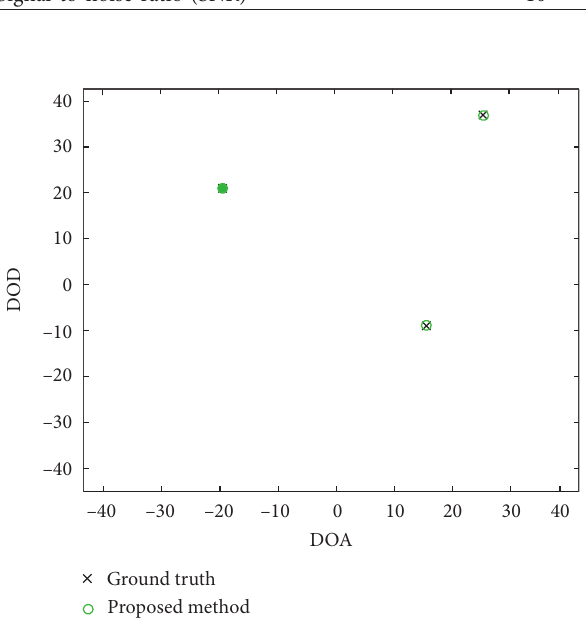
Figure 2: Location finding of the proposed algorithm.